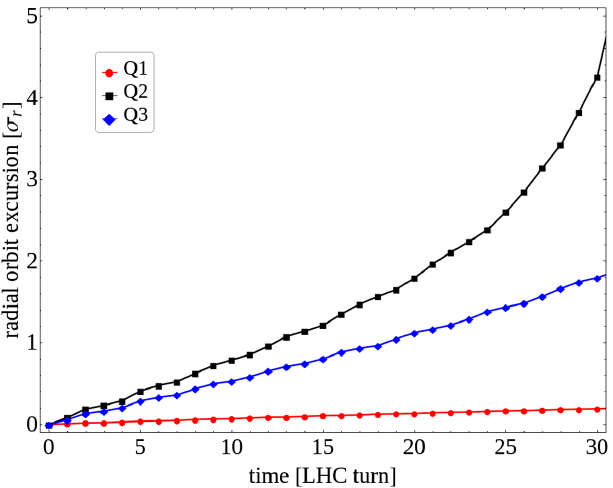
FIG. 10. The orbit excursion induced by a CLIQ discharge using the new baseline in the three types of triplet magnets Q1, Q2 and Q3. For each type, only the magnet with the largest kick is